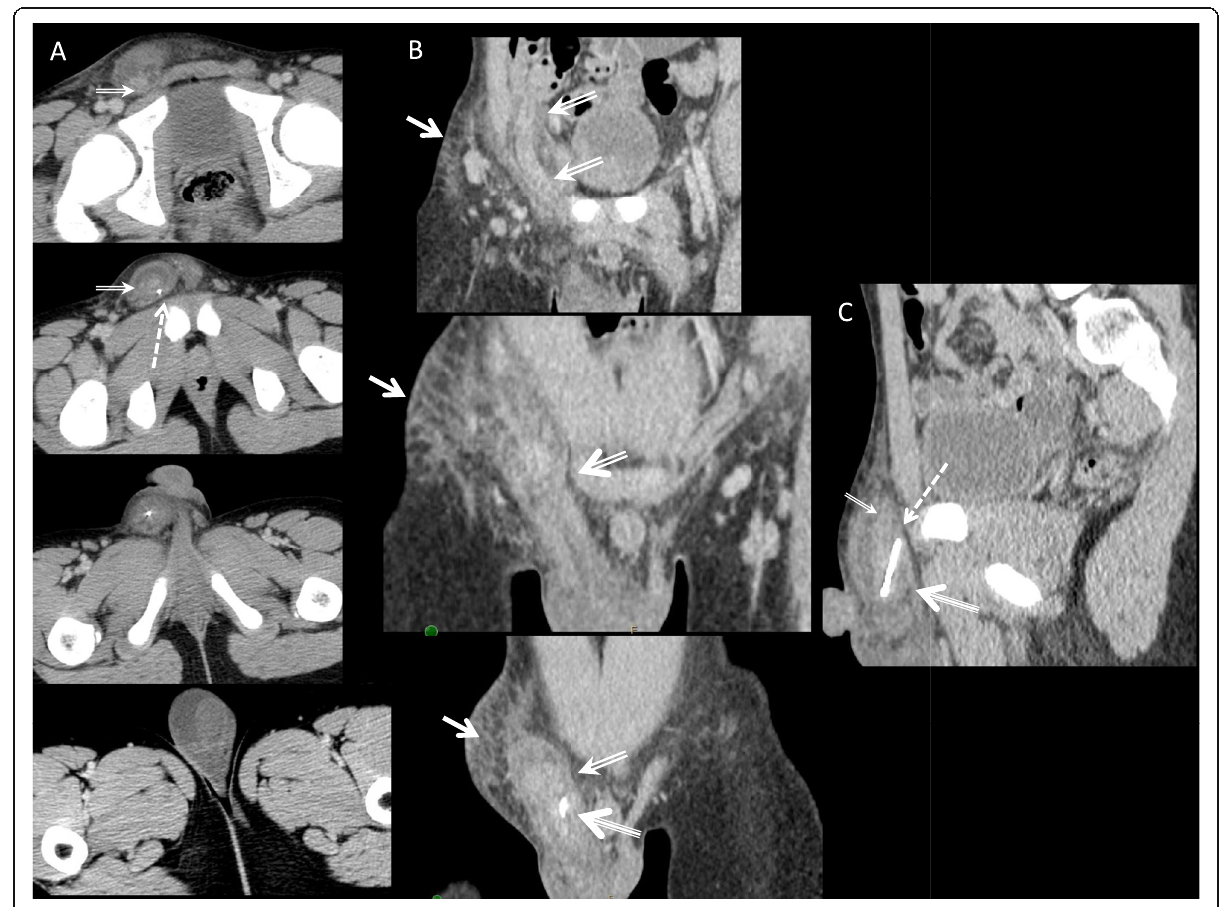
Fig. 2 a Successive axial CT images from the inguinal canal to the scrotum show the needle-filled appendix becoming thicker inferiorly within the hernia sac, fluid within the sac, and the needle tip passing posterior and outside of the appendiceal lumen. The most inferior slice shows the testis and small hydrocele. b Successive coronal reformatted CT images show the appendix connecting to the cecal tip and passing into the inguinal canal with surrounding subcutaneous fat stranding. c Sagittal image of the right inguinal canal showing the superior end of the needle passing through the posterior wall of the thickened appendix, with fluid in the inguinal canal. Double arrow, appendix; triple arrow, pin; dashed arrow, point where pin passes through the appendiceal wall; solid arrow, subcutaneous swelling in the